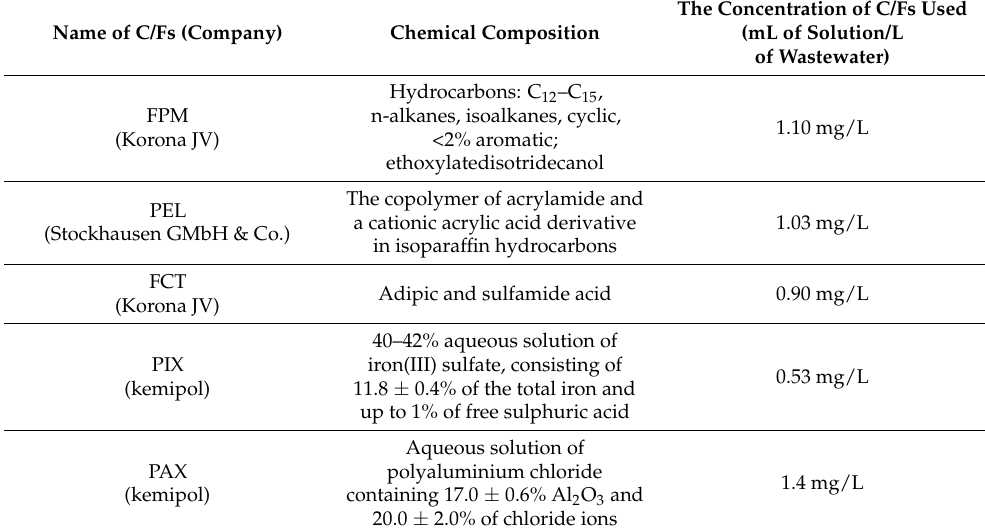
Table 1. Properties of the C/Fs.